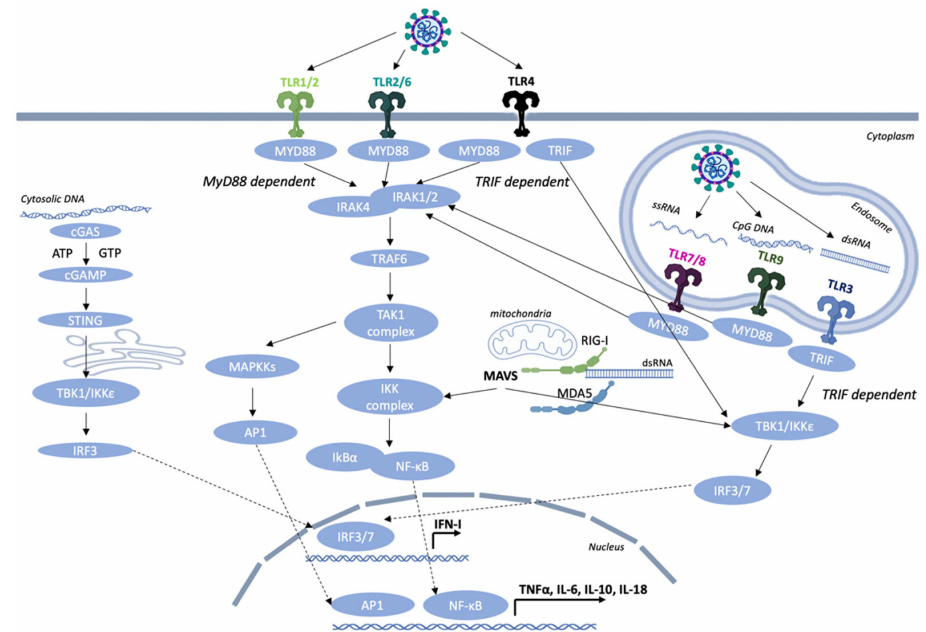
Figure 1. Innate immune cells sense viruses using distinct pattern recognition receptors